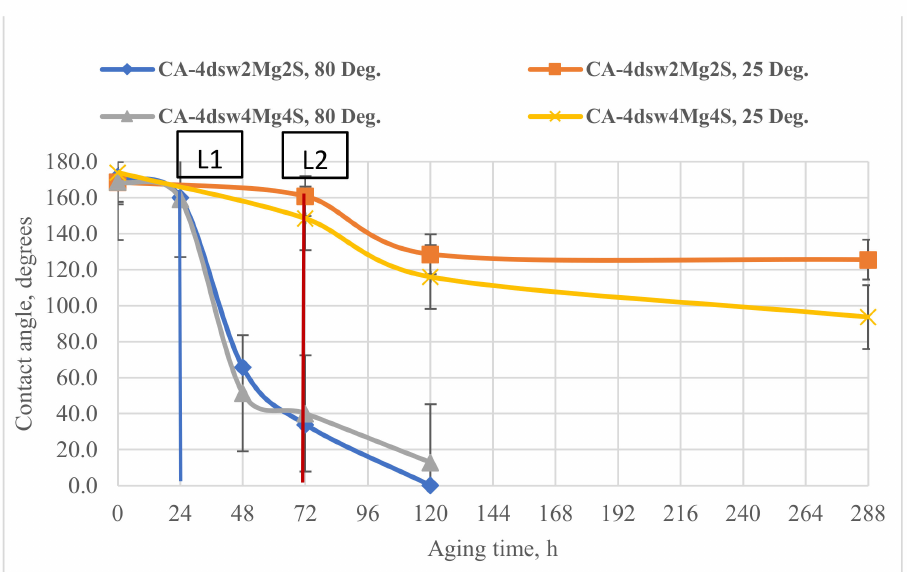
Figure 15. Effect of active ions (Mg 2+ and SO 42 − ) on the performance of EW and EW-NF, at room temperature and an elevated in situ temperature of 80 ◦